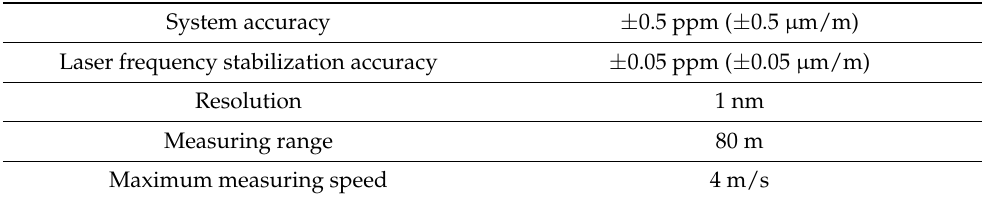
Table 1. Parameters of RENISHAW XL-80 interferometer.